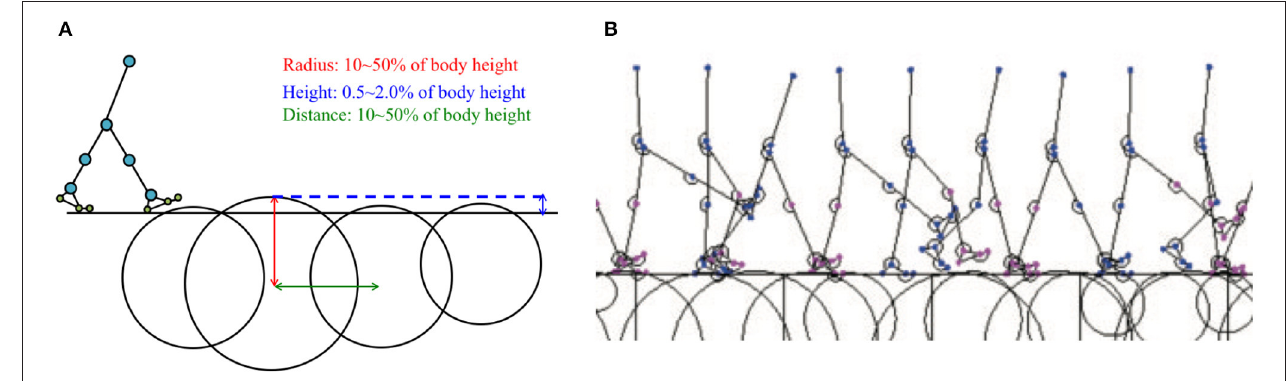
FIGURE 8 | (A) Example of simulated environment used to verify model adaptability to uneven terrain. (B) Example of stick model completing five walking periods on uneven terrain (Model 3 with PC, Supplementary Movie 1